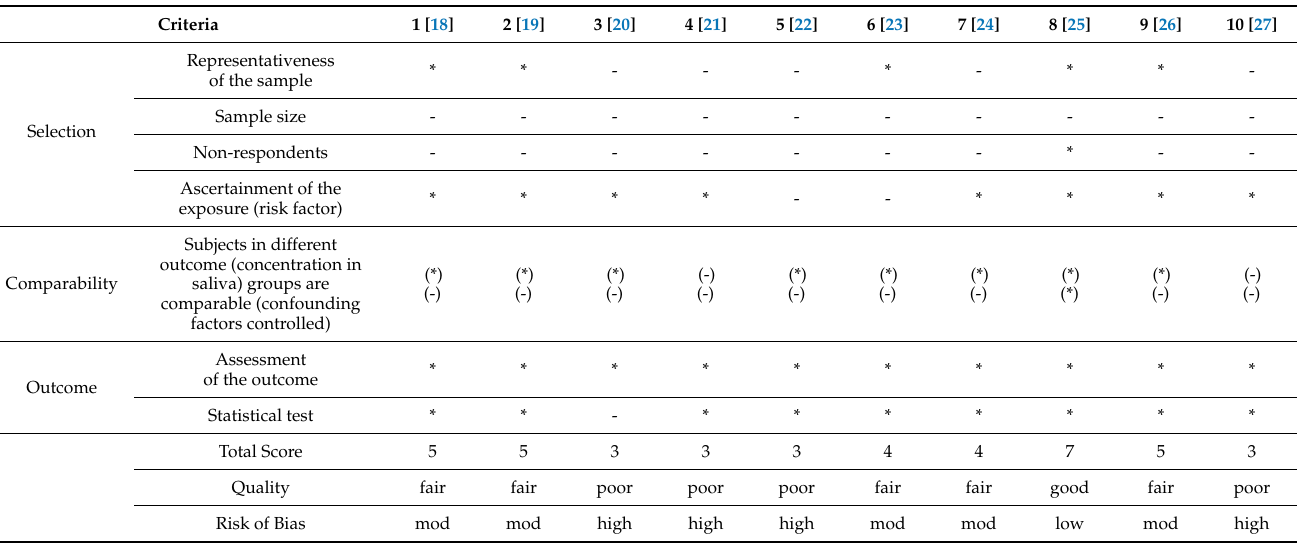
Table 5. Quality assessment of case–control studies for amyloid- β and tau according to the customized Newcastle–Ottawa Scale